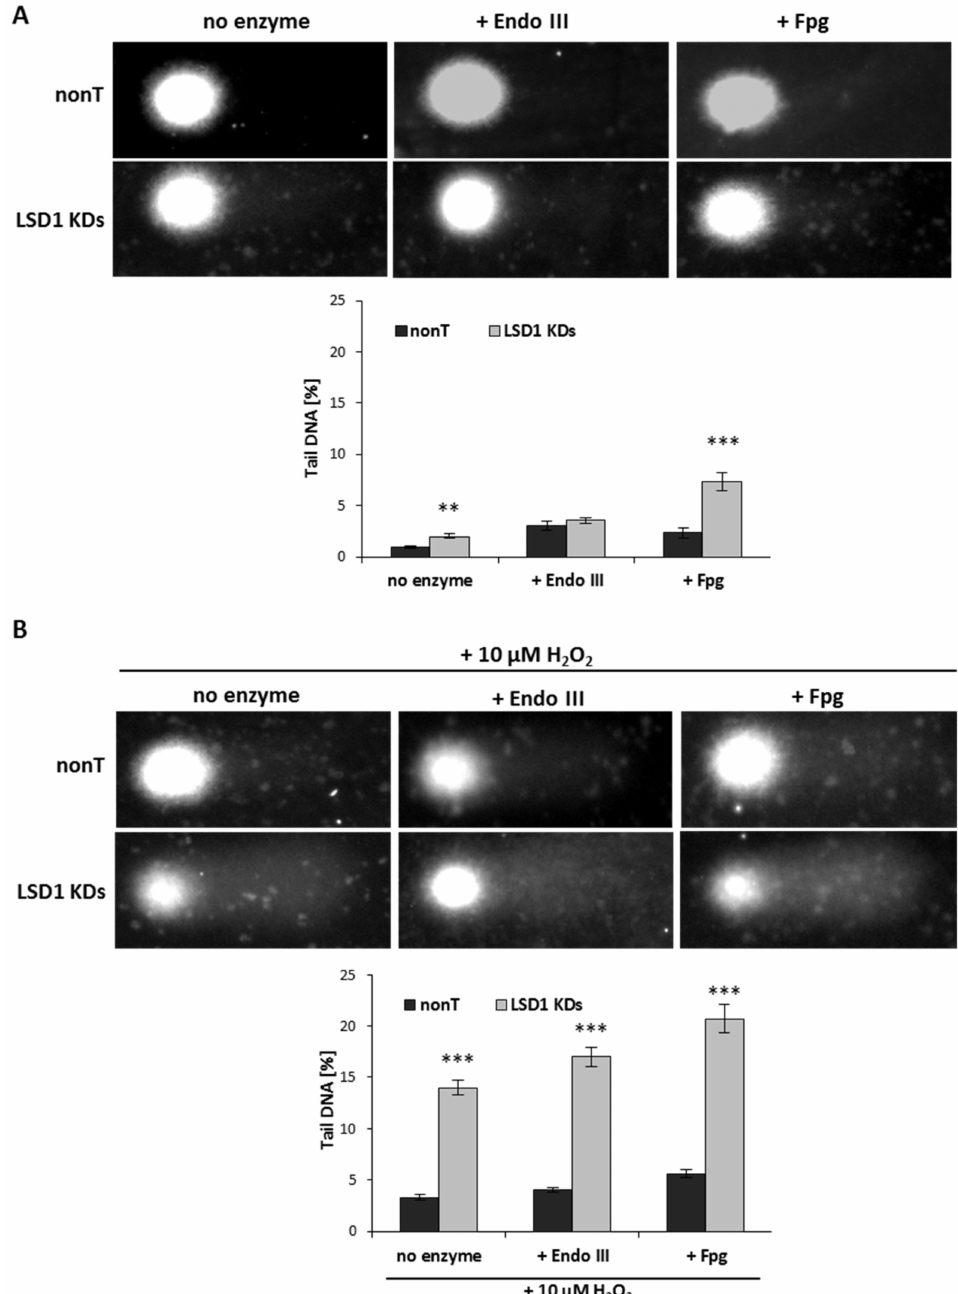
Figure 4. The tail moment (TM) of oxidatively damaged DNA in the nonT and LSD1 KDs HMEC-1 evaluated by alkaline and modified comet assay using lesion-specific enzyme endo III (endonuclease III) and FPG (formamidopyrimidine glycosylase) to di ff erentiate DNA double-strand breaks (cells untreated) from oxidized purines ( + endo III) and pirymidines ( + Fpg). ( A ), ( B ) All the values are expressed as mean ± SD (the number of cells used per repeat, n = 100). The level of significance was determined at *** p < 0.001 and ** p < 0.01 nonT vs. LSD1 KDs (ANOVA and post hoc analysis by Tukey’s